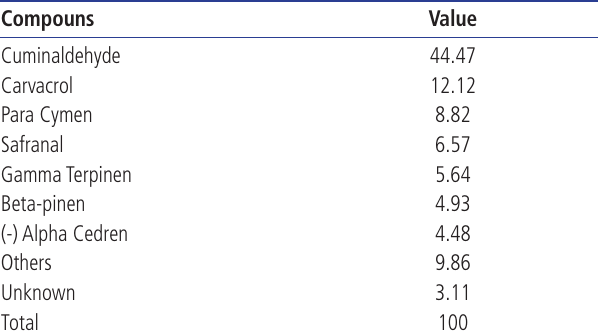
Table 1. The chemical composition of cumin essential oil (%) Compouns